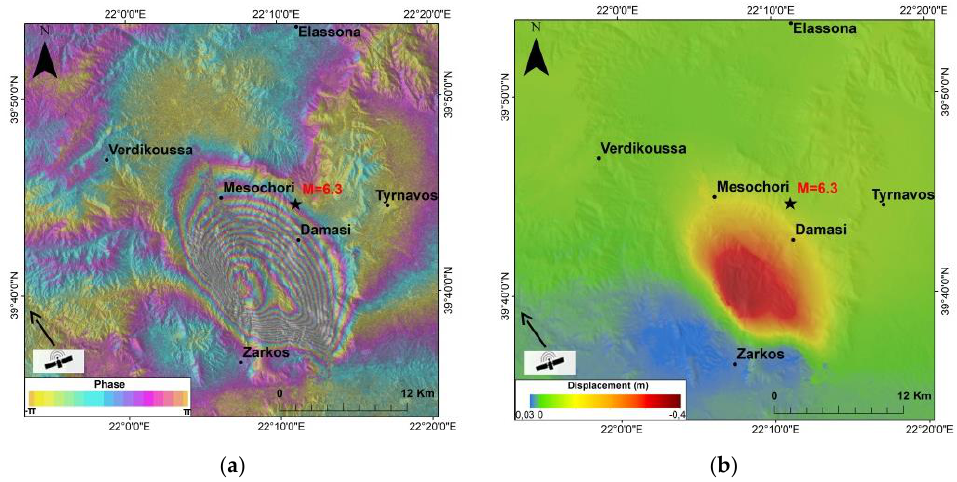
Figure 9. ( a ) Wrapped interferogram and ( b ) LoS displacement for the first seismic event of 3 March 2021 from master and slave images taken in ascending mode on 25 February 2021 and 3 March 2021, respectively; star shows relocated epicenter.